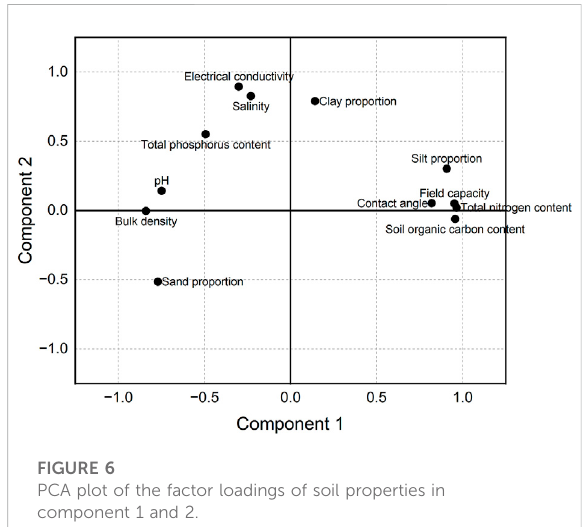
FIGURE 6 PCA plot of the factor loadings of soil properties in component 1 and 2.